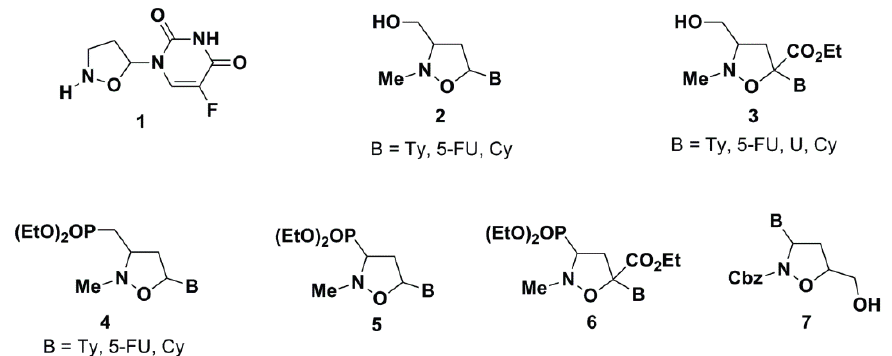
Figure 1. N , O -modified